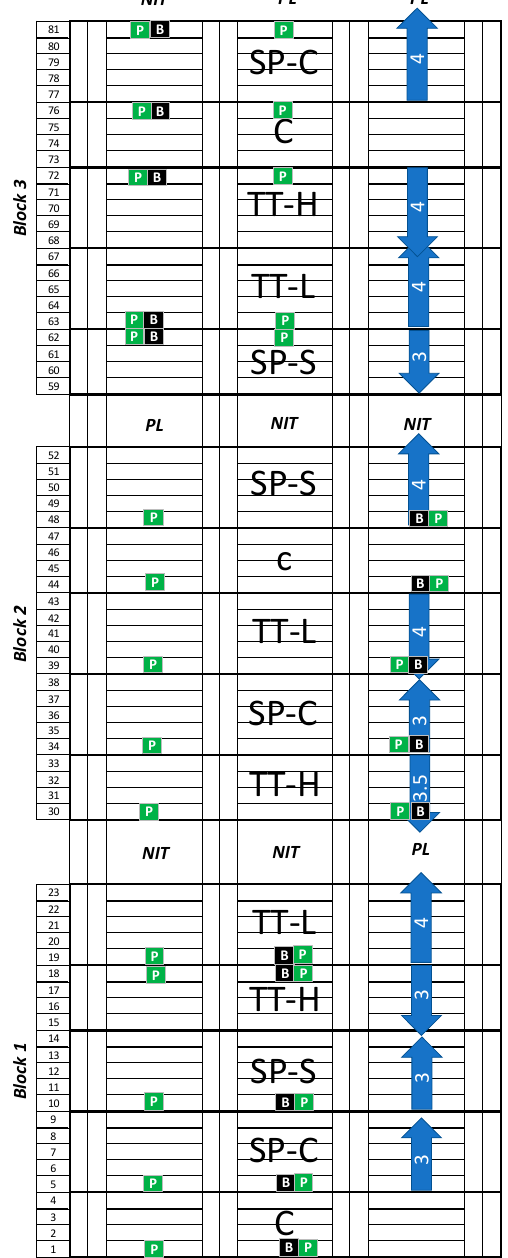
Figure 1. Experimental plan with a two-factor strip-plot design. The two tested tillage methods, ploughing or inversion tillage (PL) and non-inversion tillage (NIT) were whole plot (three per block- vertical) treatments. The slurry application methods, self-propelled slurry spreader, in crab